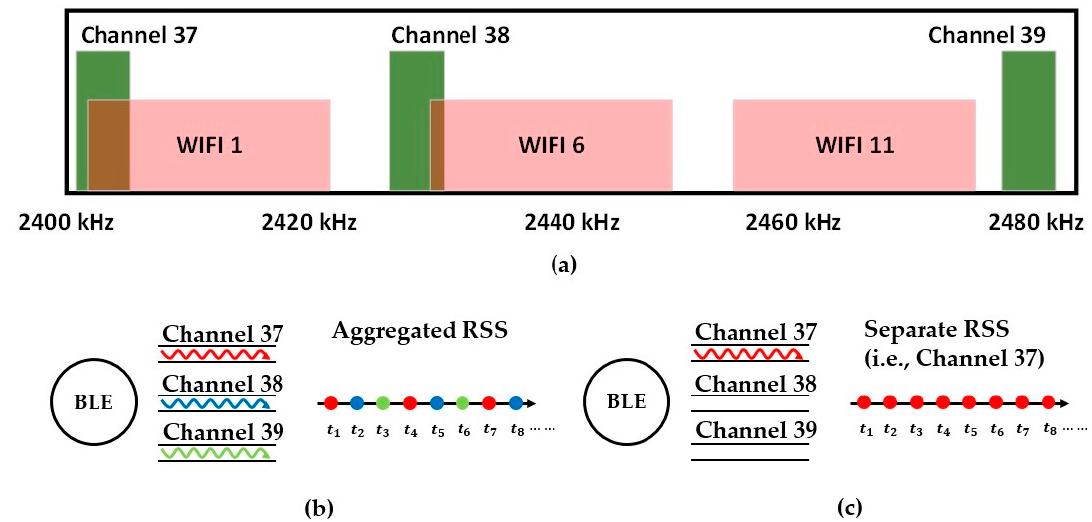
Figure 1. ( a ) The three advertising channels of BLE and the three most common WiFi sub-bands. Channels 37, 38 and 39 are the advertising channels of BLE. The workflow of ( b ) aggregated RSS and ( c ) Separate RSS (i.e., Channel ( c ) Separate RSS (i.e., Channel 37).